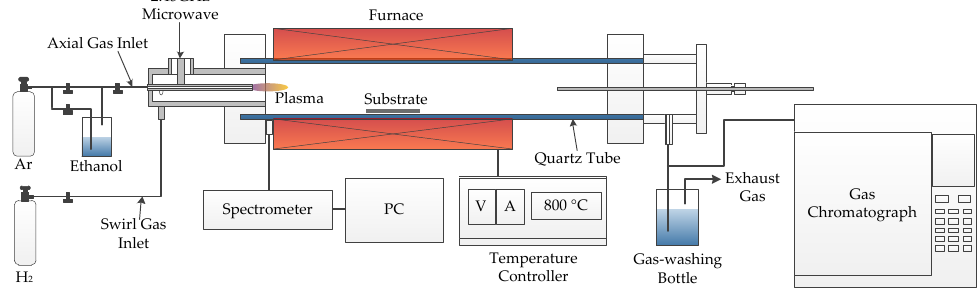
Figure 1. Schematic diagram of the atmospheric pressure microwave plasma chemical vapor deposition (AMPCVD) used for carbon nanotube (CNT) synthesis.